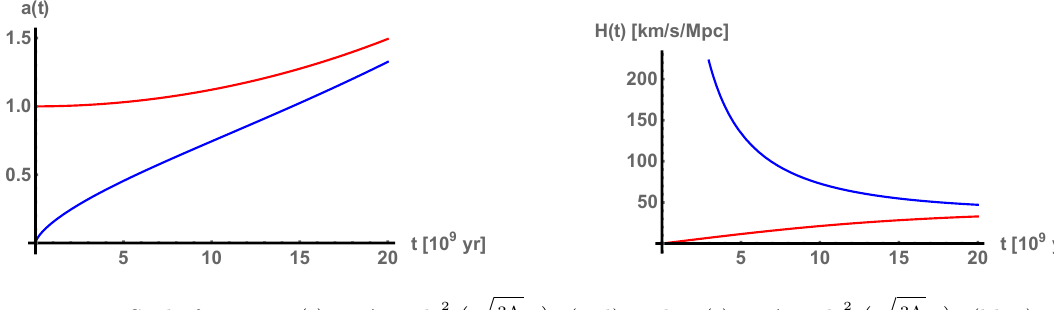
Figure 2 . Scale factors a 3 ( t ) = A cosh 2 3 on the left side. The corresponding Hubble parameters H